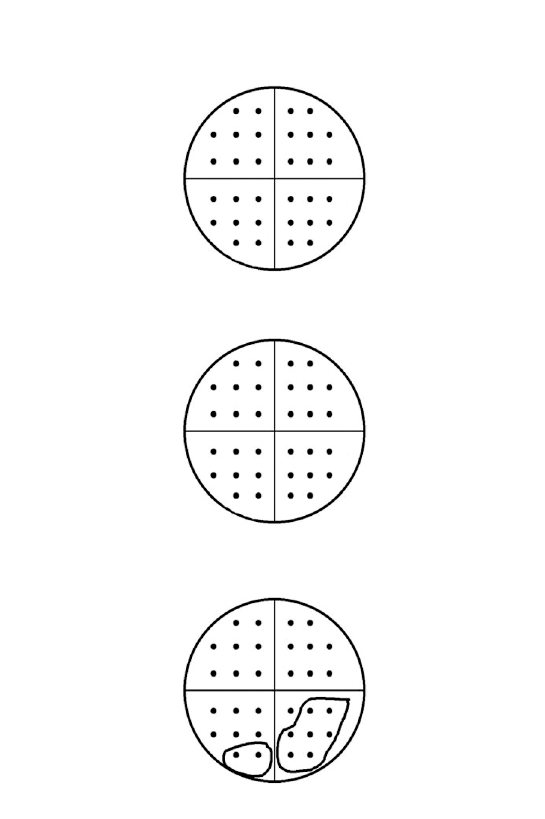
Figure 3 – Sheet of paper showing 3 transversal whole sections of a prostate and 12 quadrants each one with 8 equidistant points in a total of 96 points. Tumor extent corresponds to 9 positive